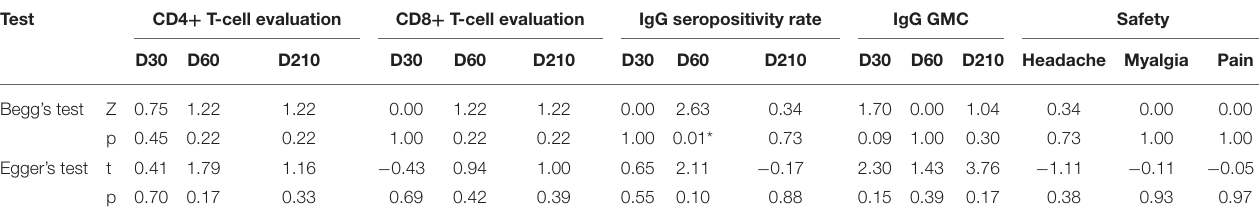
TABLE 2 | Publication bias test.